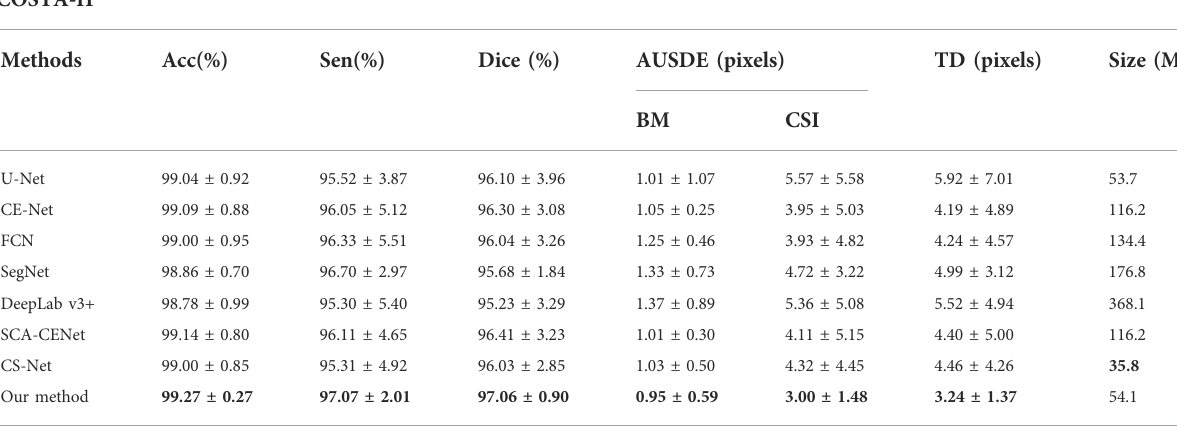
TABLE 1 Quantitative segmentation results of different deep learning methods on the COSTA-H dataset.